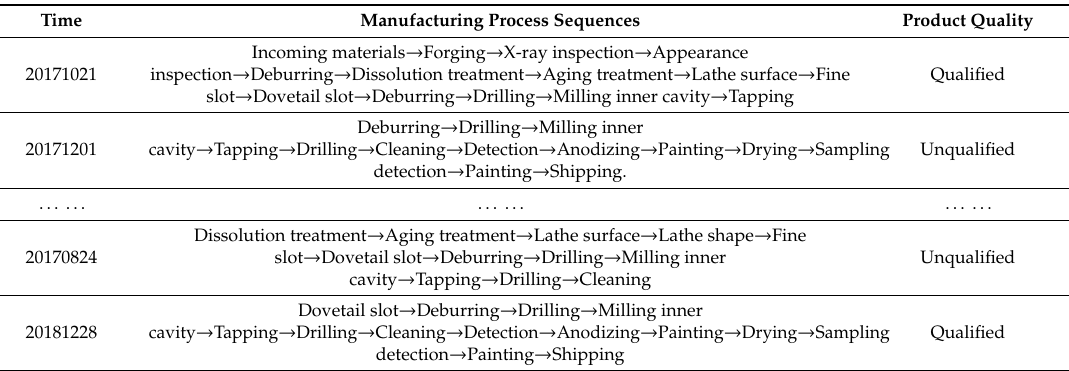
Table 5. Input data